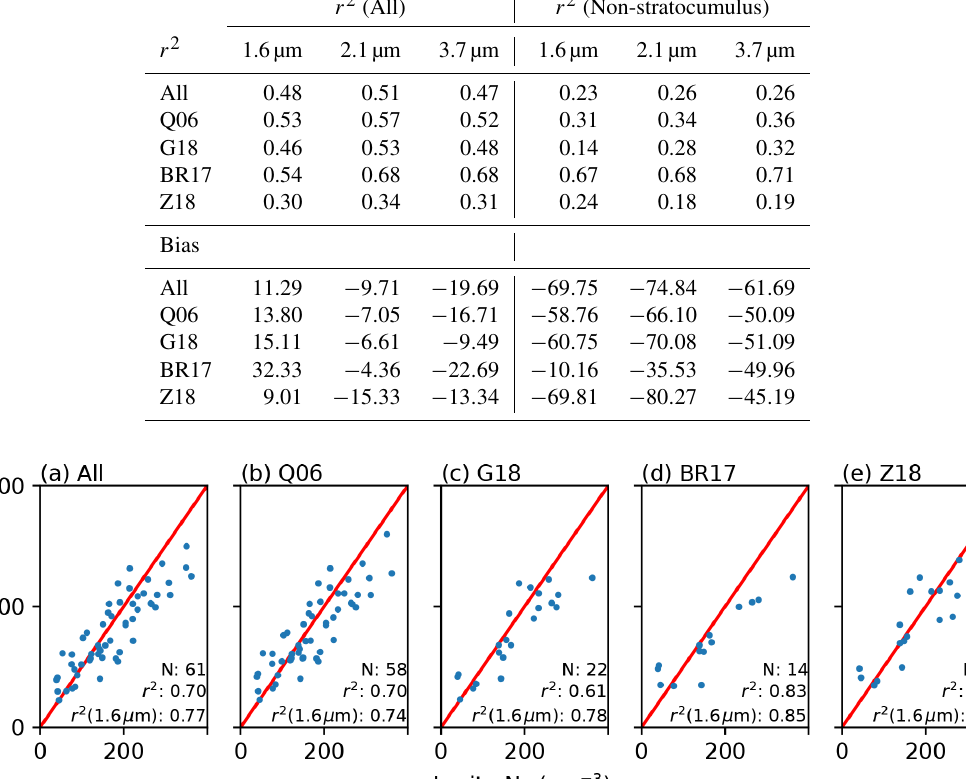
Figure 5. Comparison of 1 ◦ × 1 ◦ mean in situ and MODIS N d . Requires at least 300 in situ measurements and 2000 valid MODIS retrievals in a grid box. Each scatterplot also shows the number of points and the r 2 value, along with the r 2 value for the 1.6µm retrieval in the bottom right. The 1.6µm retrieval is used, as it offers the best correlation to in situ N d at 1 ◦ × 1 ◦